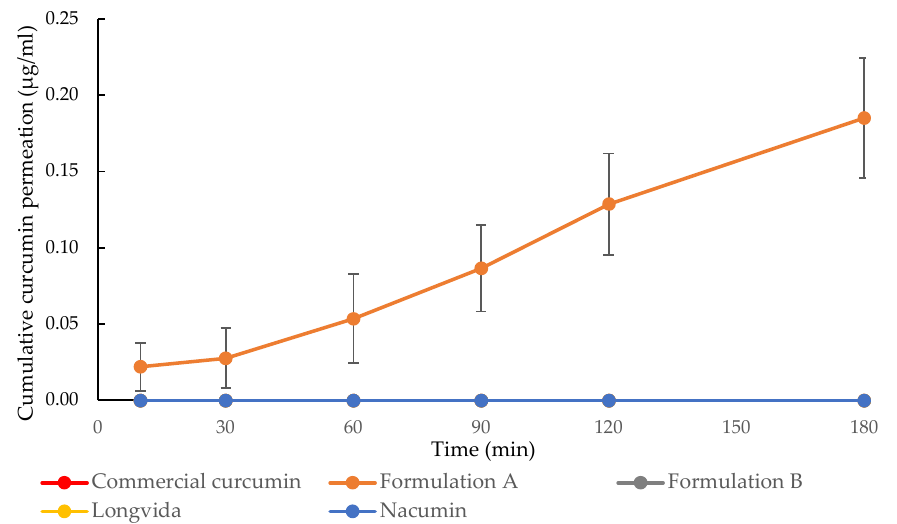
Figure 13. Cumulative amounts of curcumin passing through the Caco-2 cell monolayers from the basolateral to the apical chambers, B-A ( n = 9, mean ± SD). The TEER of the Caco-2 cell layers in the in vitro transport study was measured before and after each experiment. As shown in Table 5, at the end of the drug transport experiment, the TEER readings significantly decreased ( p ≤ 0.05) for all the test samples. Table 5. Average TEER readings of the Caco-2 cell monolayers at the start and end of the in vitro drug transport experiment (Ω cm 2 ) ( n = 9; mean ± SD). At t = 0 min After t = 180 min